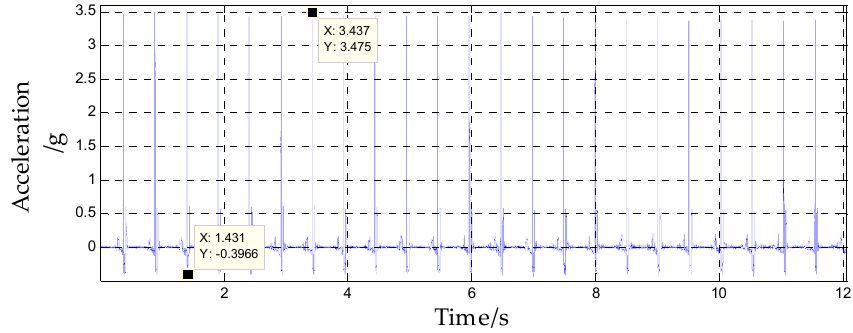
Figure 15. Acceleration of the system spindle direction.